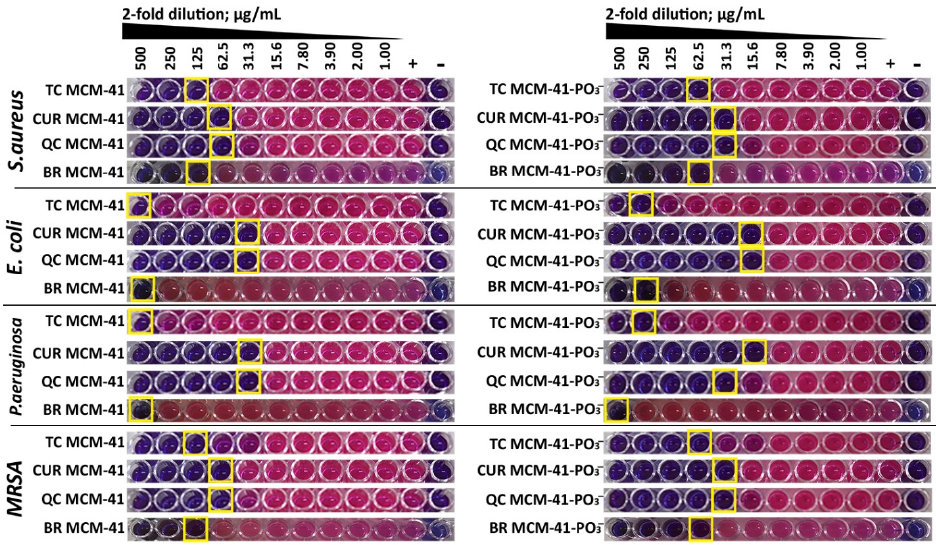
Figure 5. Determination of MIC values for each SrtAI (TC, CUR, QC, BR)-loaded MCM-41 and MCM-41-PO 3 − MSN against S. aureus (MSSA) ATCC25923, MRSA ATCC43300, E. coli ATCC25922, and P. aeruginousa ATCC27853 using a BMD assay with resazurin colorimetric readout. Yellow boxes indicate the MIC value for each formulation. Table 3. MIC values for each SrtAI (TC, CUR, QC, BR)-loaded and non-loaded MSN or AMP (PEX, INDO, MASTO) against S. aureus ATCC25923 (MSSA), MRSA ATCC43300, E. coli ATCC25922, and P. aeruginousa ATCC27853 derived from a BMD assay with resazurin colorimetric readout.